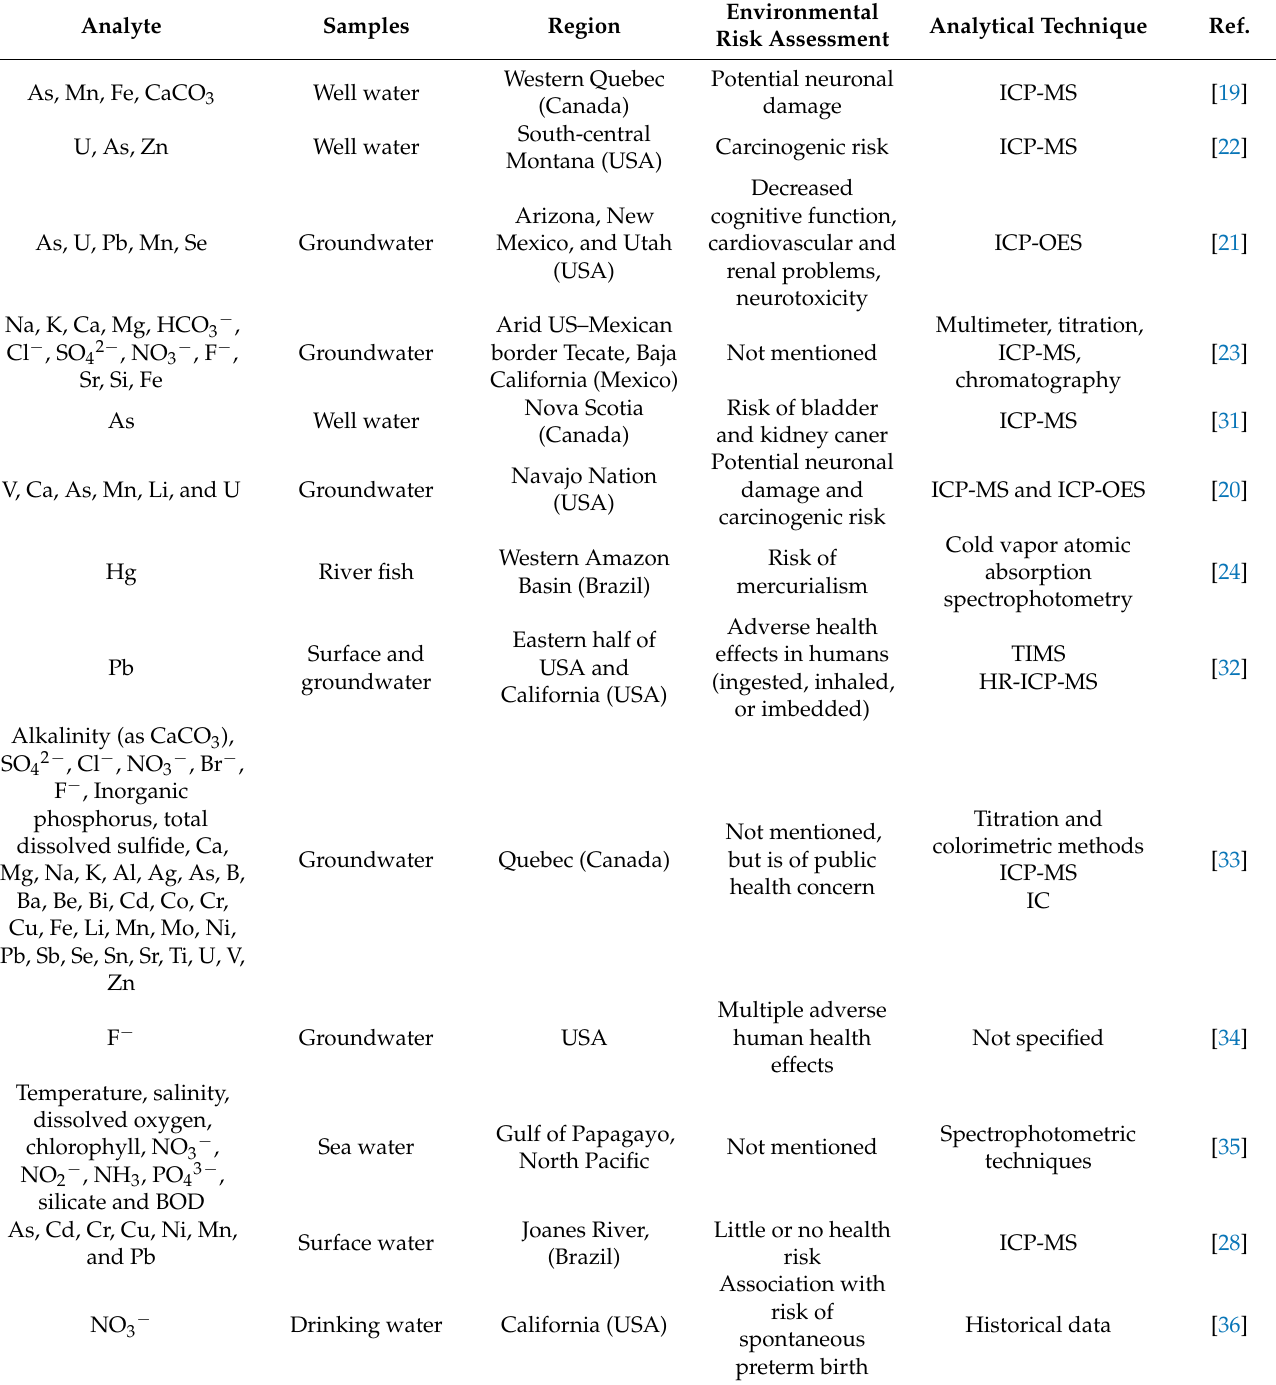
Table 1. Detection of inorganic pollutants in environmental